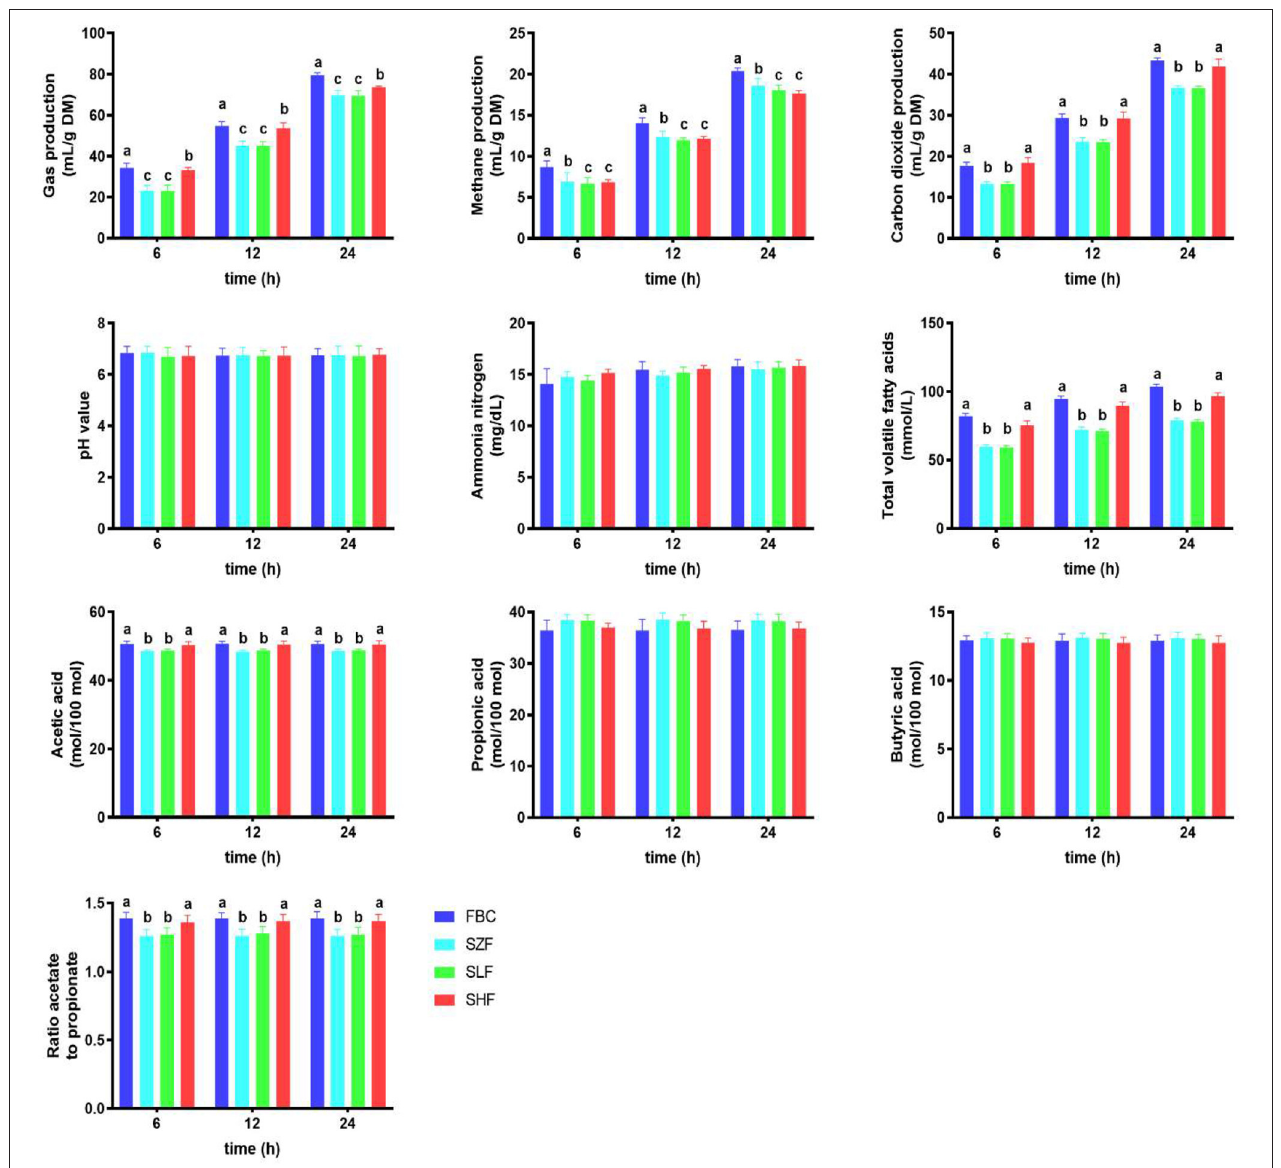
FIGURE 3 | Selected ruminal biogas of black cane prior to ensiling (pre-ensiled materials) and silages treated with ferrous sulfate heptahydrate, at three time points (6, 12, 24h) during the in vitro rumen incubation (means ± SEM; n = 18). FBC, pre-ensiled materials; SZF, ensiled FBC + 0% ferrous sulfate heptahydrate; SLF, ensiled FBC + 0.015% ferrous sulfate heptahydrate; SHF, ensiled FBC + 0.030% ferrous sulfate heptahydrate. a − c A different superscript in similar sampling time indicates a significantly different mean ( P <